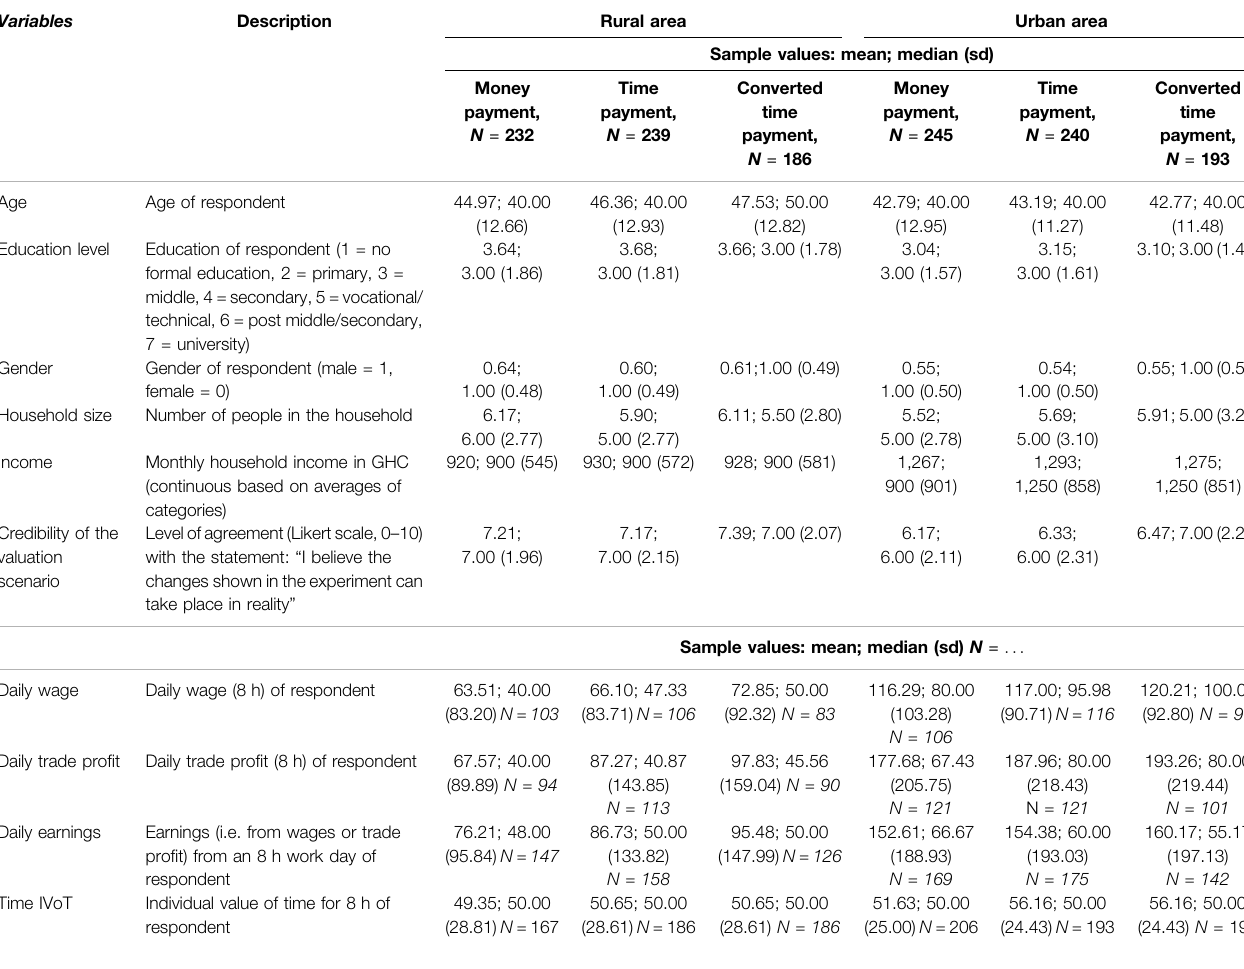
TABLE 3 | Data characteristics for the three samples (money payments, time payments, converted time payments sample) in each